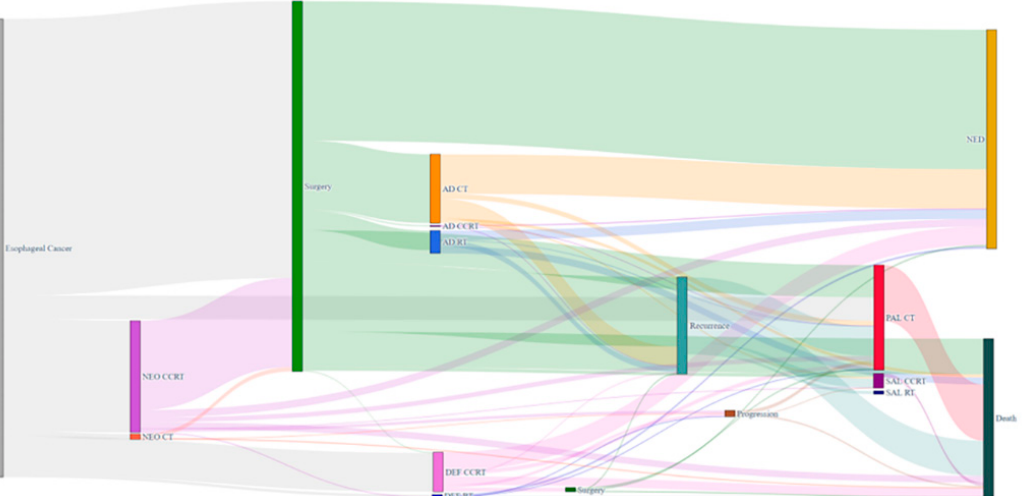
Figure 3. Sankey diagram for visualization of treatment and outcome patterns for 2 years after di-